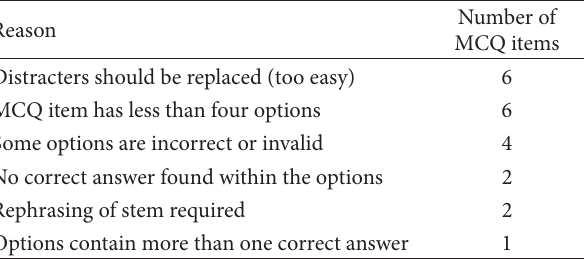
Table 6: Reasons for MCQ major modifications.